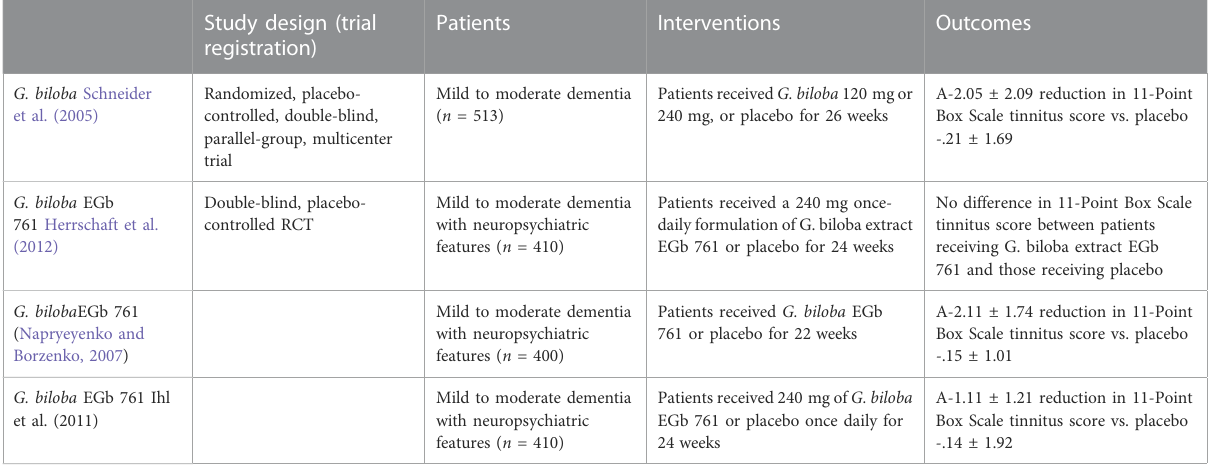
TABLE 2 G. biloba in the treatment of mild to moderate dementia. Study design (trial